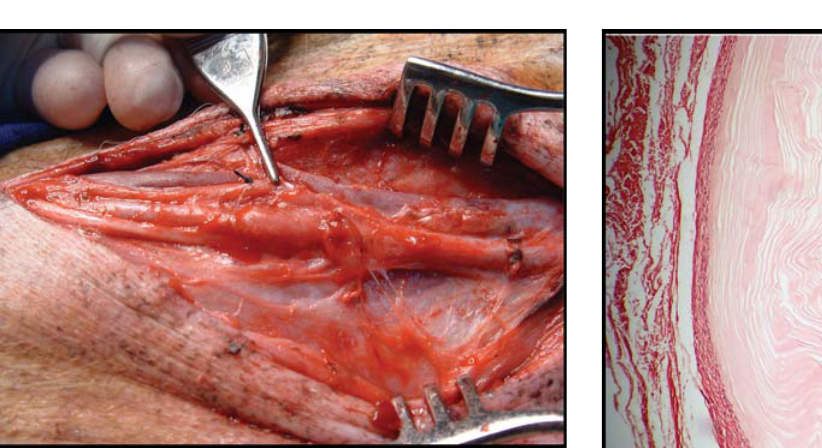
FIGURE 2 - Femoral artery with sugarcane biopolimer membrane patch after 180 days.